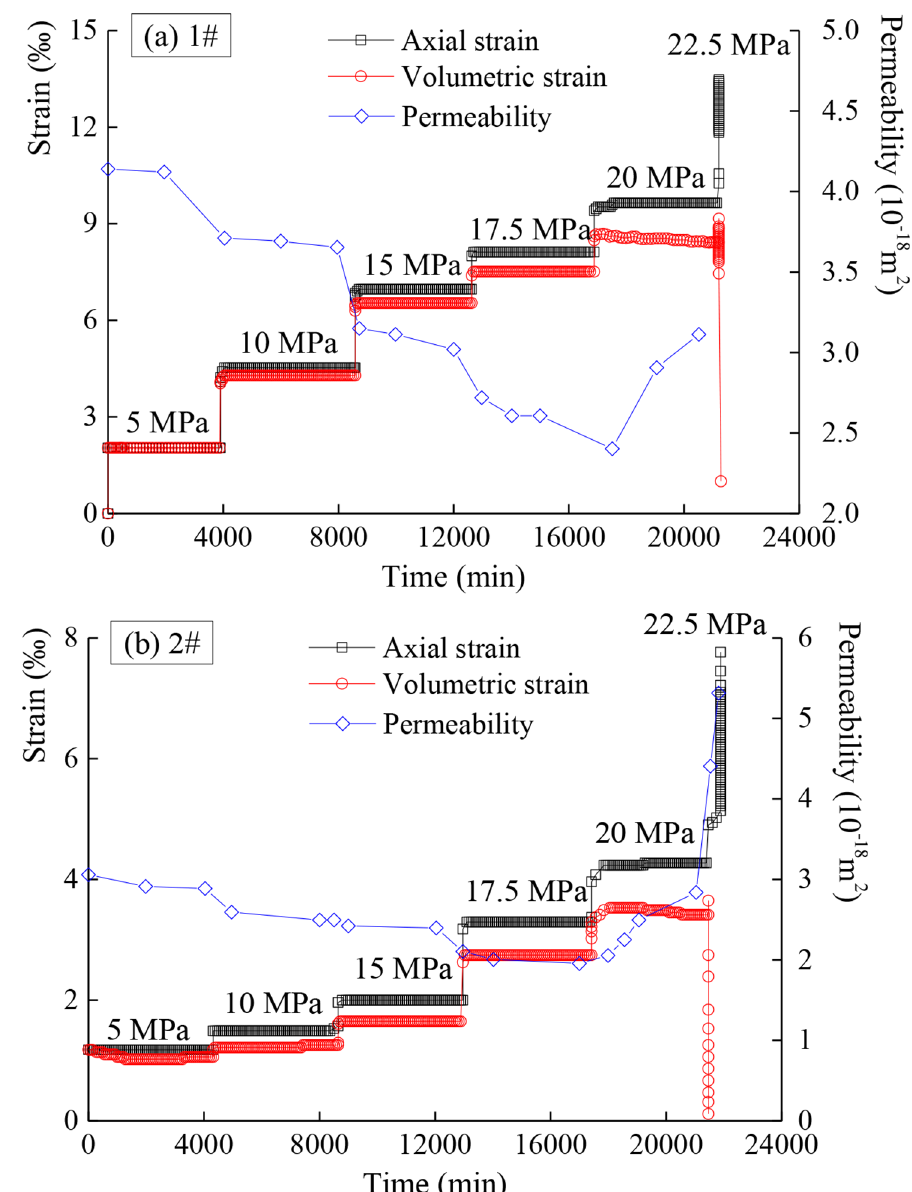
Fig. 3 Strain and